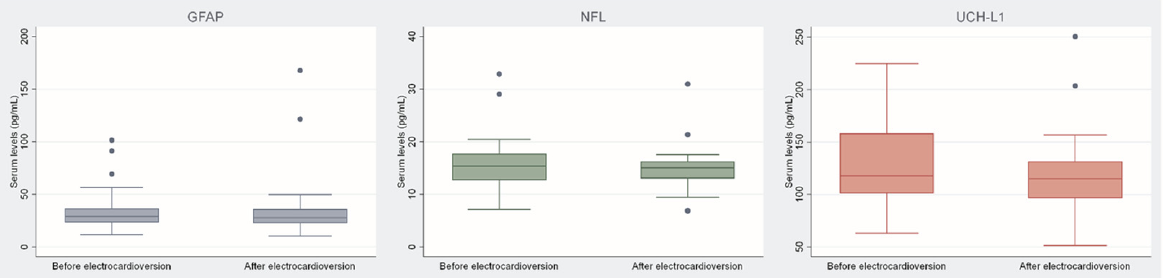
Figure 2. Comparison of biomarkers within the atrial fibrillation group based on the electrical cardioversion. Legend: GFAP—glial fibrillary acidic protein; NFL—neurofilament light chain; UCH-L1—ubiquitin C-terminal hydrolase L1.